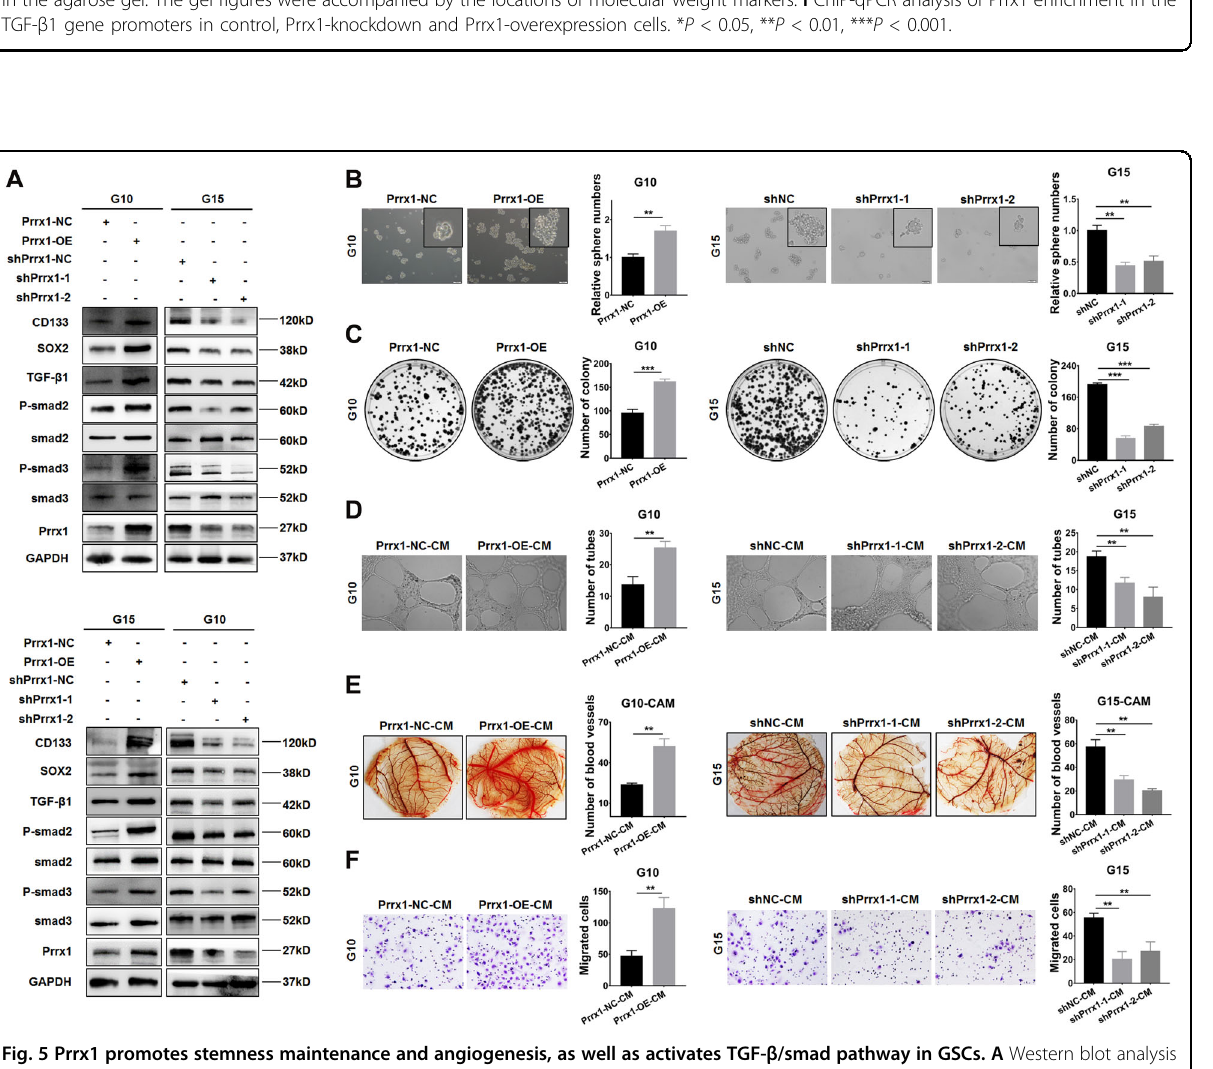
Of fi cial journal of the Cell Death Differentiation